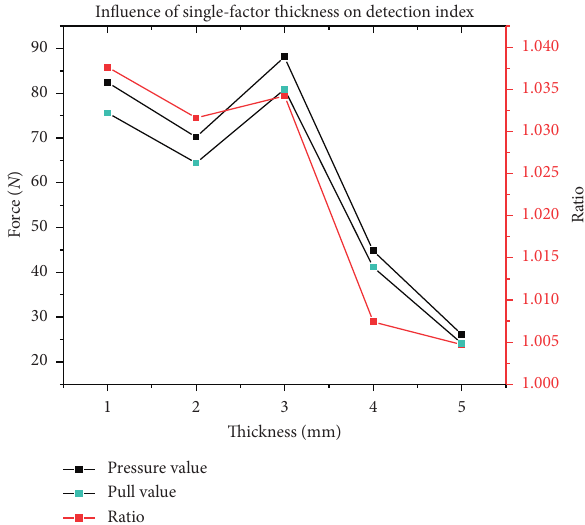
Figure 8: Impact of rubber thickness on detection